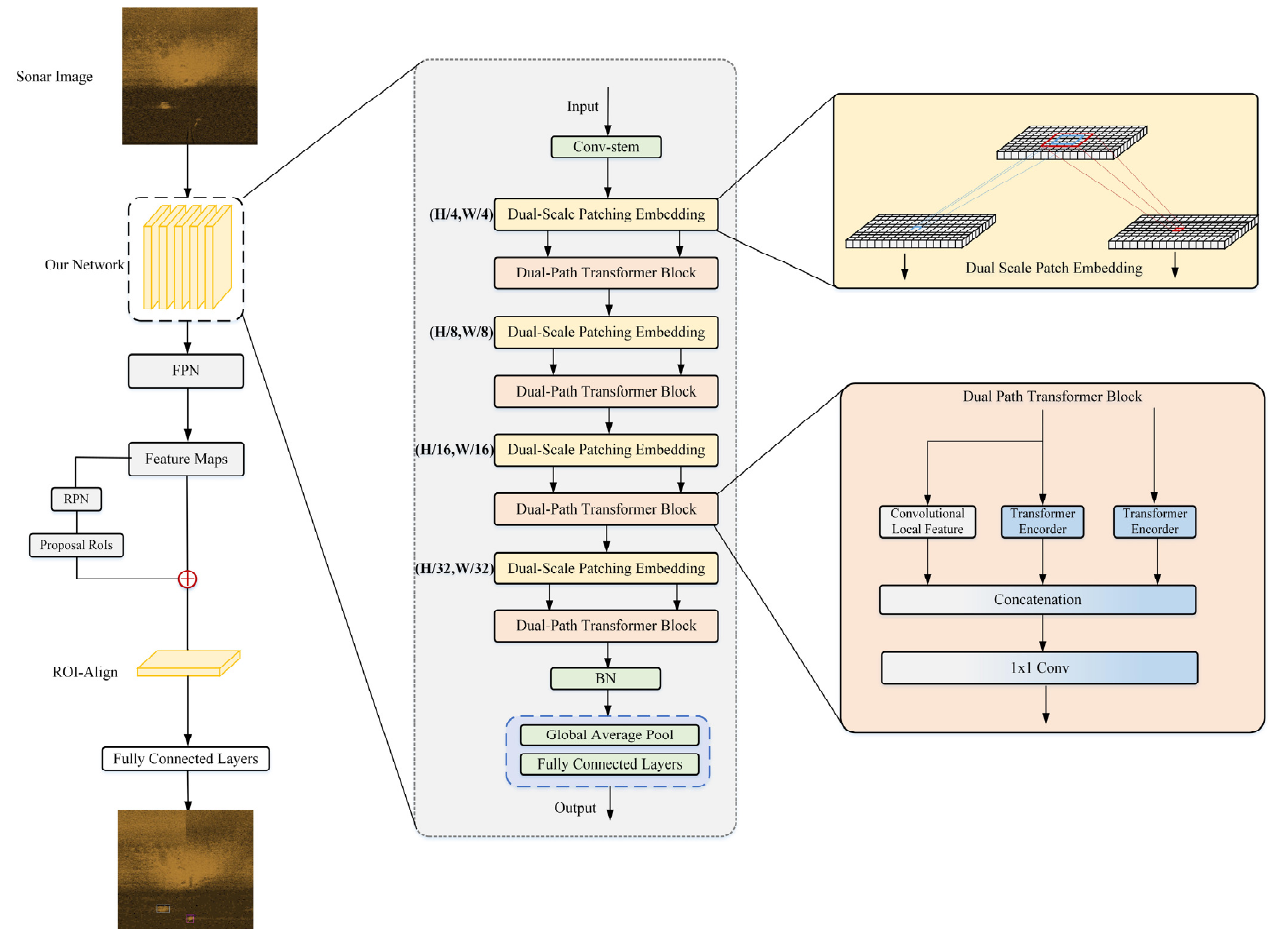
Figure 1. The middle column of the proposed DP-ViT framework includes Dual Scale Patching Embedding and Dual Path Transformer Block. On the right is the detailed visualization of dual scale and transformer block in patch embedding.